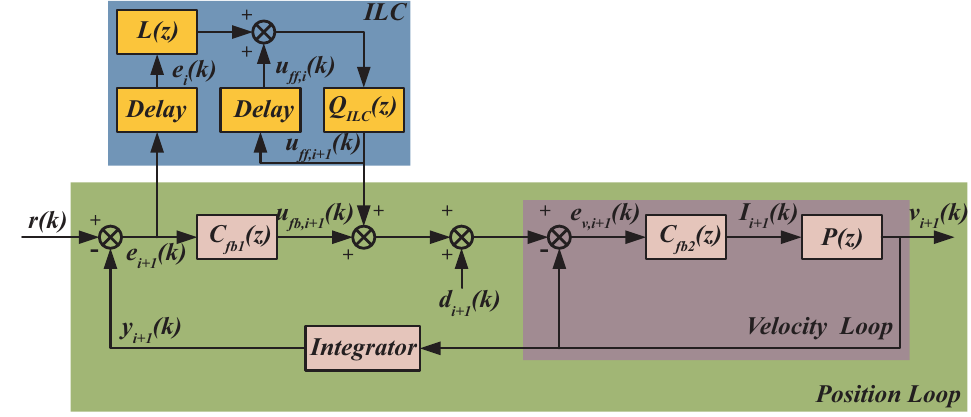
Figure 3. The controller framework of